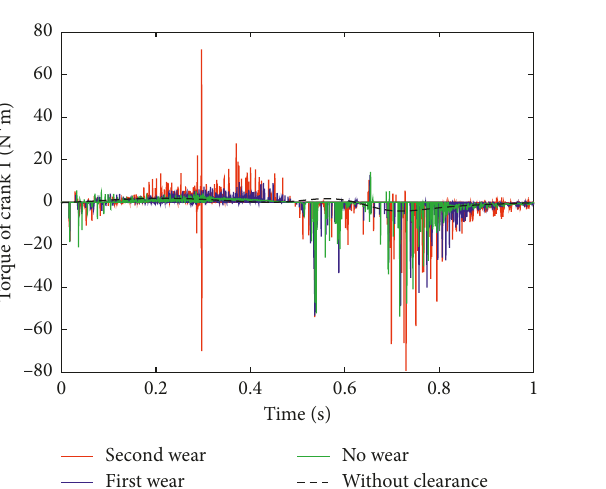
Figure 21: Input torque of crank 1.